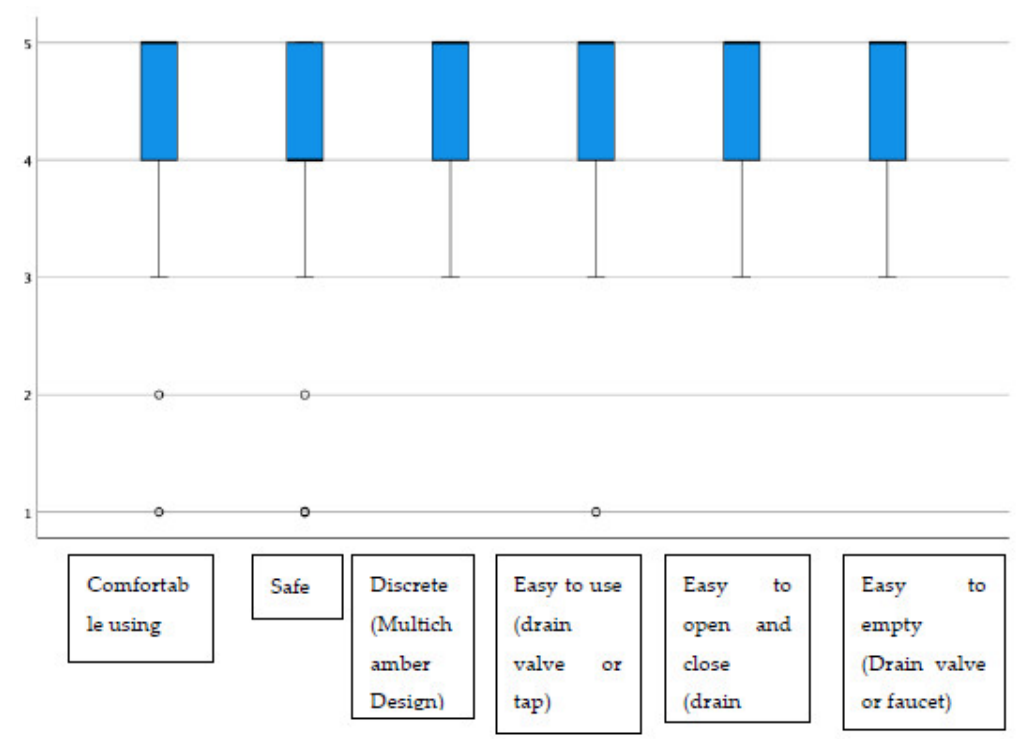
Figure 3. Distribution of scores in evaluating the usefulness of the urostomy device. Table 5. Adverse events and